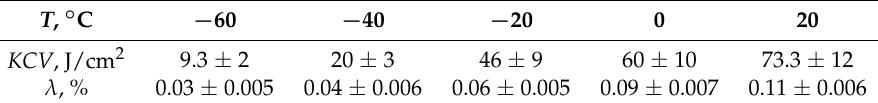
Table 1. Impact toughness and maximum contraction ratio of specimens λ (%) in the crack growth